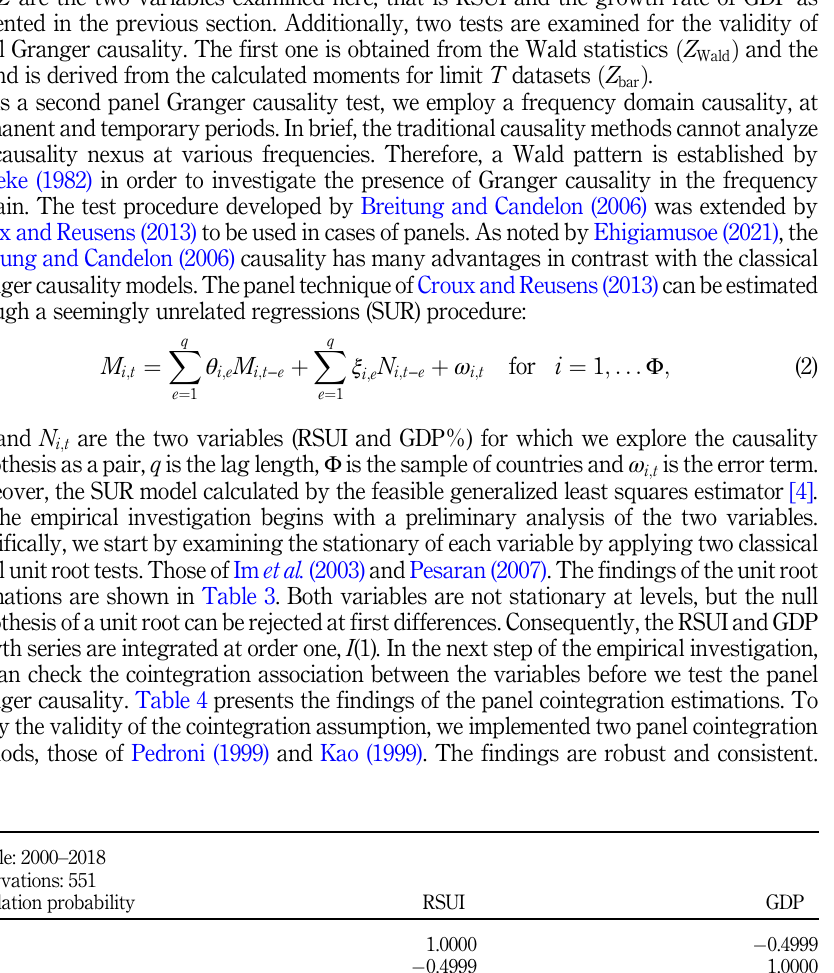
Table 2. Panel correlation